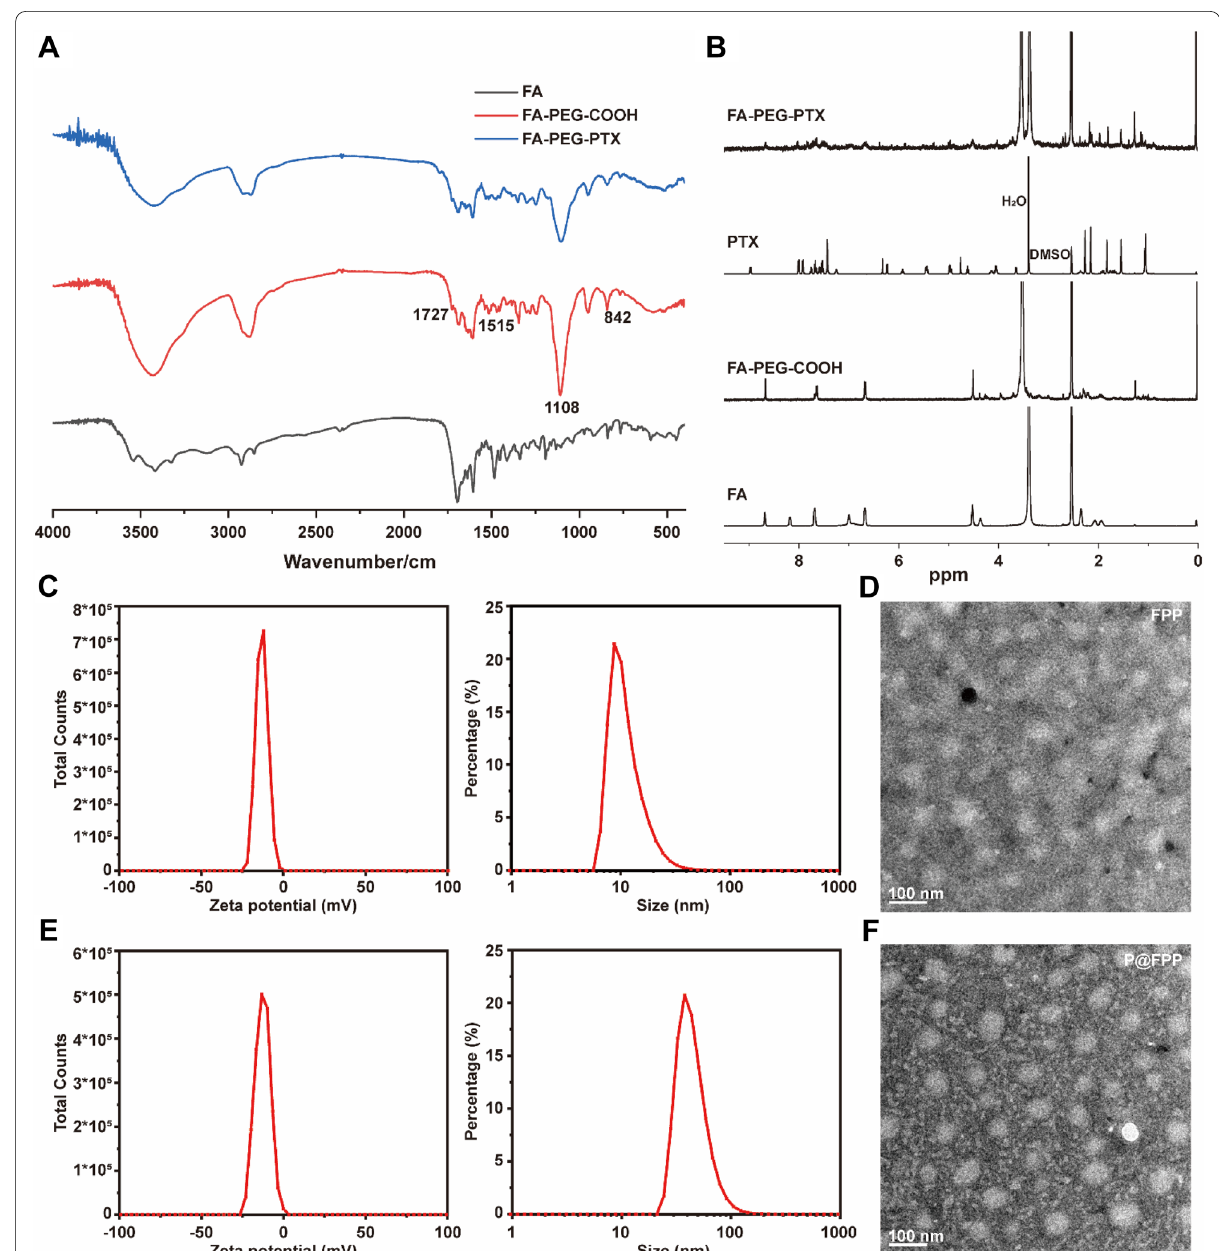
Fig. 3 Preparation and characterization of P@FPP NMs. A The Fourier Transform Infrared Spectroscopy (FTIR) analysis of FA, FA-PEG-COOH, and FA-PEG-PTX. B The 1 H Nuclear Magnetic Resonance Spectroscopy ( 1 H NMR) analysis of FA, PTX, FA-PEG-COOH, and FA-PEG-PTX. C The size distribution and ζ-potential of FA-PEG-PTX. D The representative transmission electron microscopy (TEM) image of FA-PEG-PTX. Scale bars: 100 nm. E The size and ζ-potential analysis of P@FPP NMs. F The TEM observation of P@FPP. Scale bars: 100